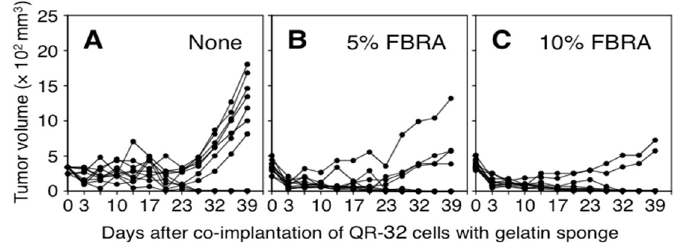
Figure 1. Growth curves of QR-32 cells co-implanted with gelatin sponge in mice. The administration of basal diet ( A ); 5% FBRA ( B ) or 10% FBRA ( C ) started two days before the co-implantation and throughout the experiment. Inflammation-related carcinogenesis was suppressed by FBRA administration.